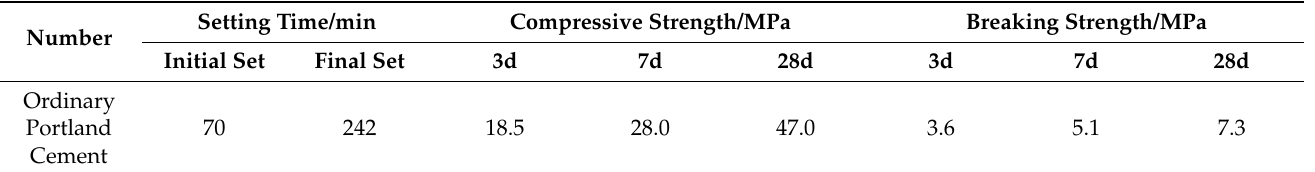
Table 1. Physical property indexes of cement.